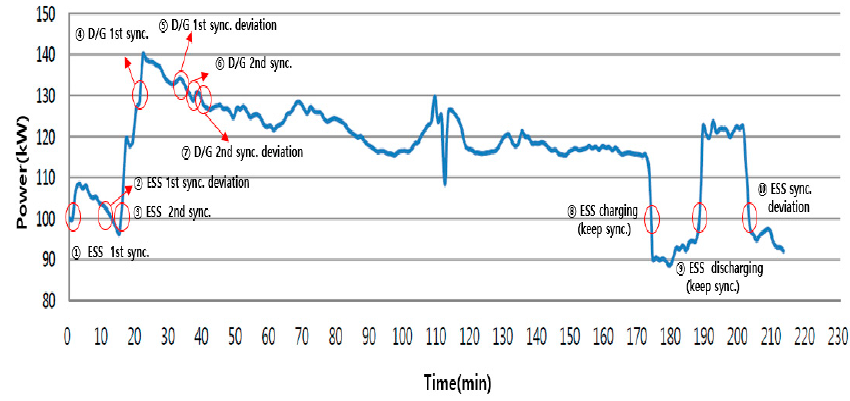
Figure 15. Synchronization and system deviation for load pattern of normal seagoing case 3. Table 8. Synchronization condition in normal seagoing case 3.